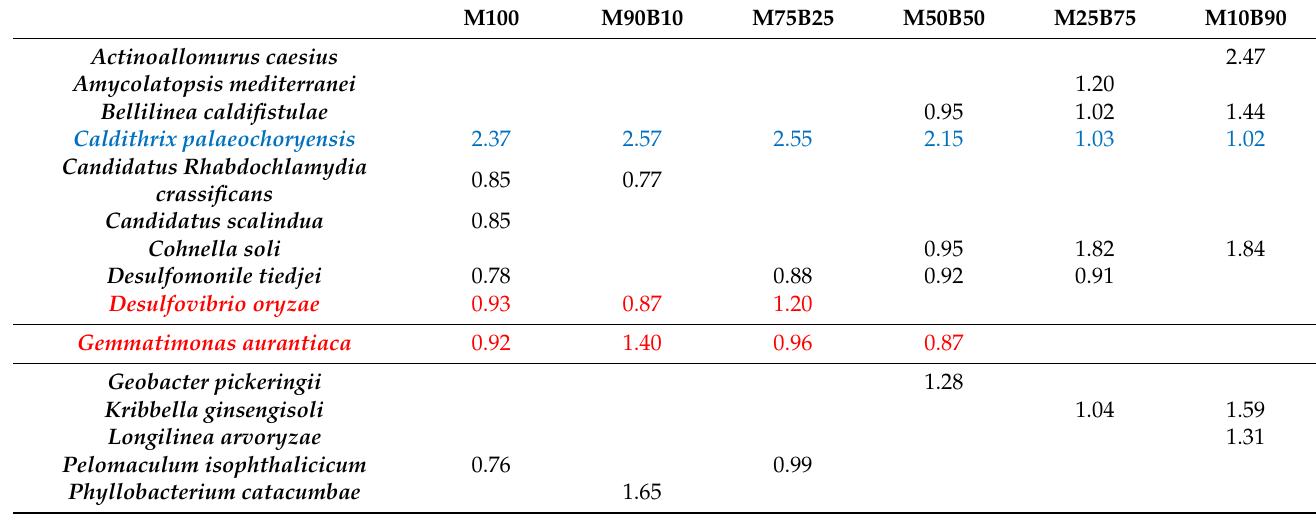
Table 9. Species classification for mud compost (M) blended with biochar (B) by percent of total nucleic acids in the sample